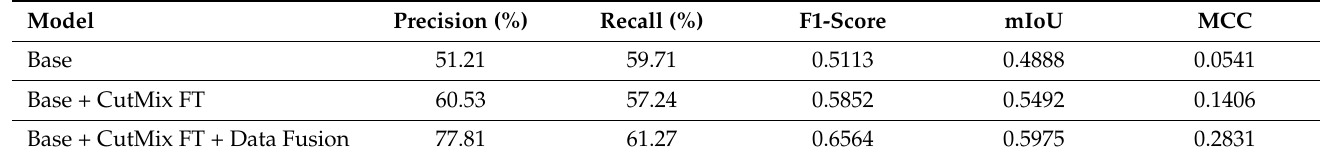
Table 1. Accuracy of models when tested against the target dataset (FT: fine-tuned).